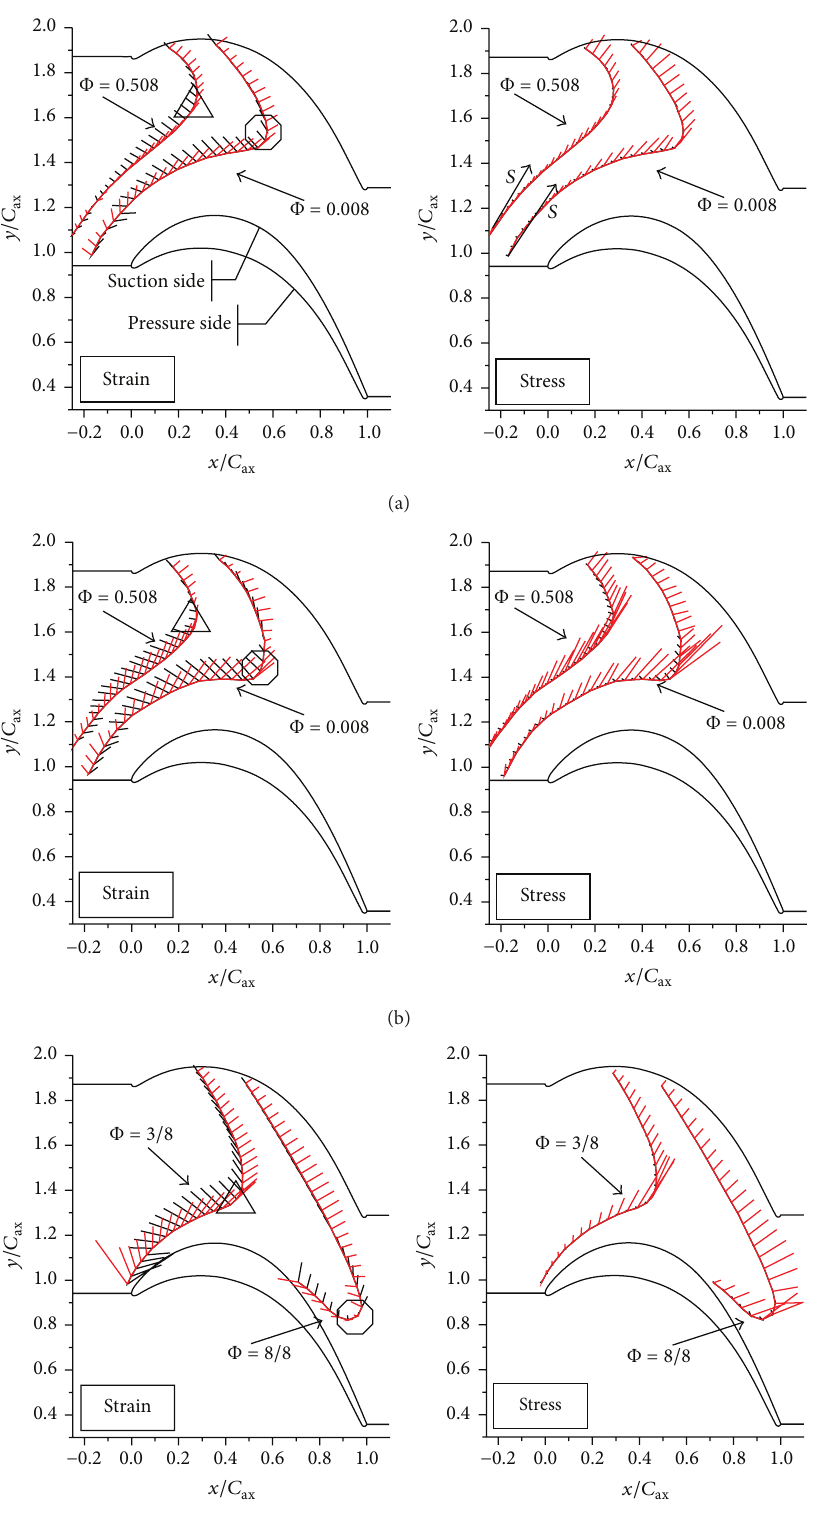
Figure 8: Eigenvectors of the strain tensor (left) and of the stress tensor (right) along two selected wakes: (a) LES: Re = 5.18 × 10 4 , (b) DNS: Re = 5.18 × 10 4 , and (c) LES: Re = 1.48 × 10 5 (for the strain tensor, the red segment represents the direction of